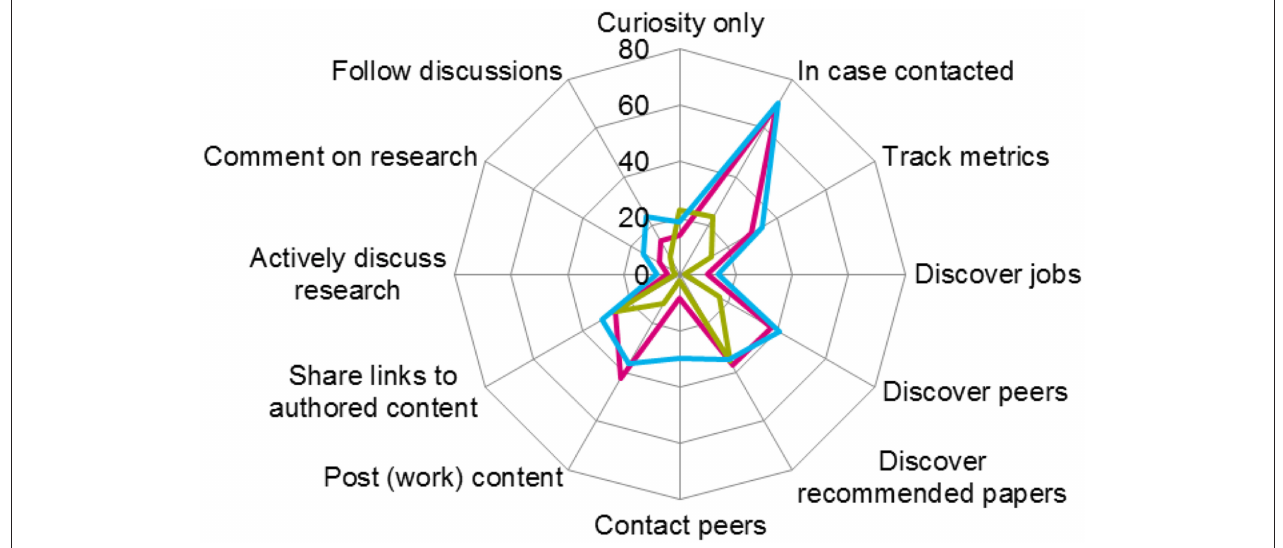
FIGURE 4 | Percentage of respondents (from a sub-sample of the Nature survey) who use different SNS for particular purposes. Academia.edu shown in magenta, Mendeley in green, and ResearchGate in blue. Redrawn from raw data (Nature Publishing Group,